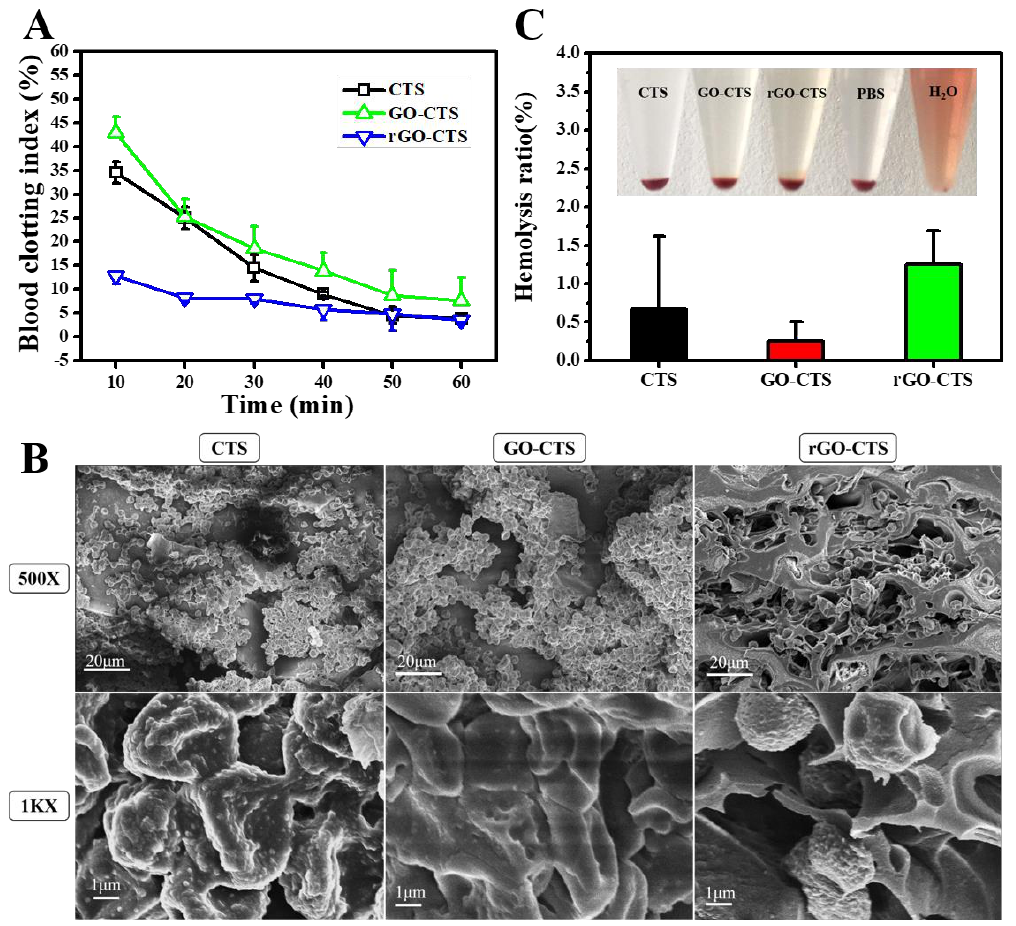
Figure 4. In vitro hemostatic capacity evaluation and hemolytic activity of the CTS, GO-CTS, and rGO-CTS cryogels. ( A ) In vitro dynamic whole-blood clotting evaluation of the CTS, GO-CTS, and rGO-CTS cryogels ( p < 0.05); ( B ) SEM images of hemocyte adhesion on the CTS, GO-CTS, and rGO- CTS cryogels; ( C ) photographs from the hemolytic activity assay of the CTS, GO-CTS, and rGO-CTS cryogels using PBS as the negative control and H 2 O as the positive control.